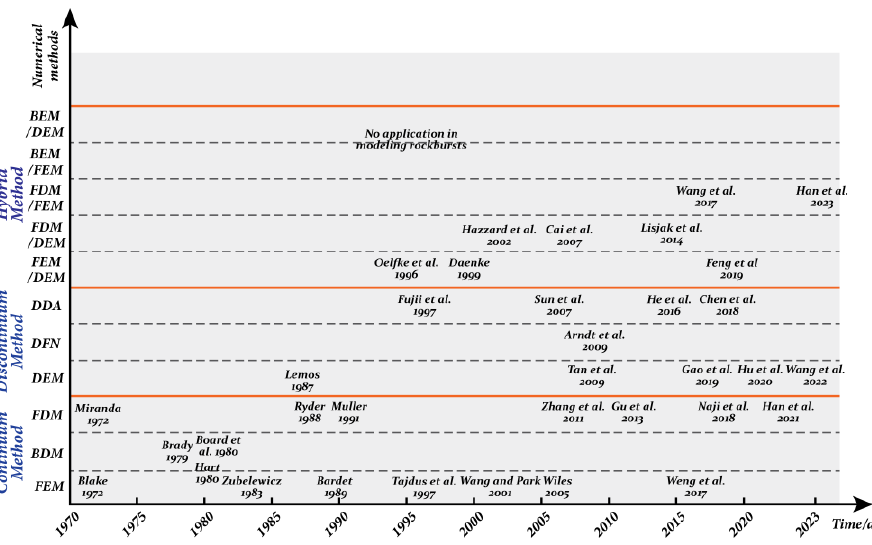
Figure 5. History of numerical methods employed in modeling rockbursts.